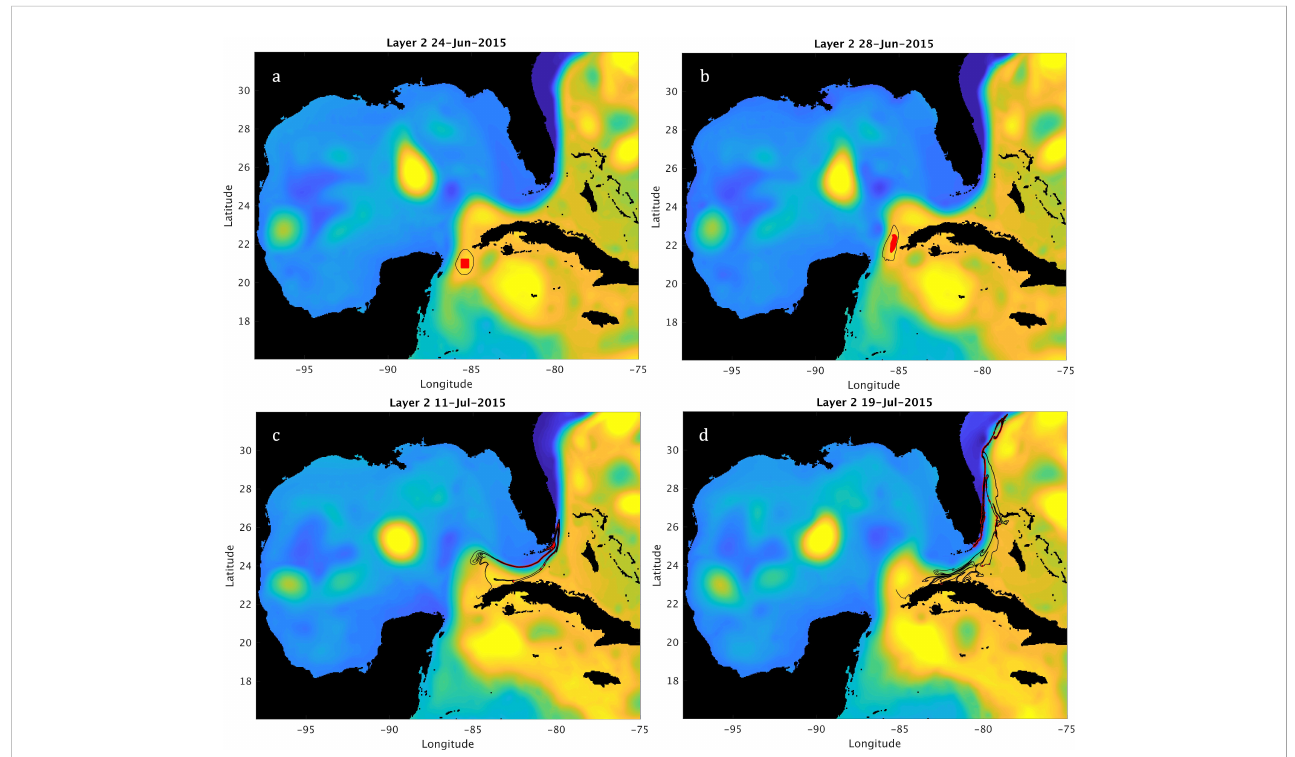
FIGURE 12 Snapshots of the coherent LCE anticyclone detected south of the Yucatan Channel (black contours), during a retracted LC phase, superimposed on model SSH. The red box in panel (A) represents the seeding location of Lagrangian particles on June 24, 2015, and the red dots in panels (B) June 28, 2015, (C) July 11, 2015, and (D) July 19, 2015 represent the particle locations after